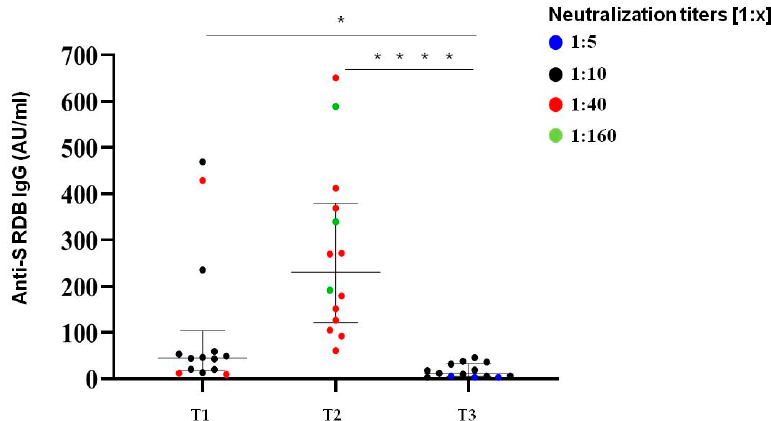
Figure 4. Anti S-RBD Ab titres measured at 30 days after the second inoculum in COVID-19 infection-naive and previous natural infection subjects with/without immuno-related diseases. Each symbol represents a single study participant. Bars represent means (one way ANOVA, (* p < 0.05; **** p < 0.0001)).